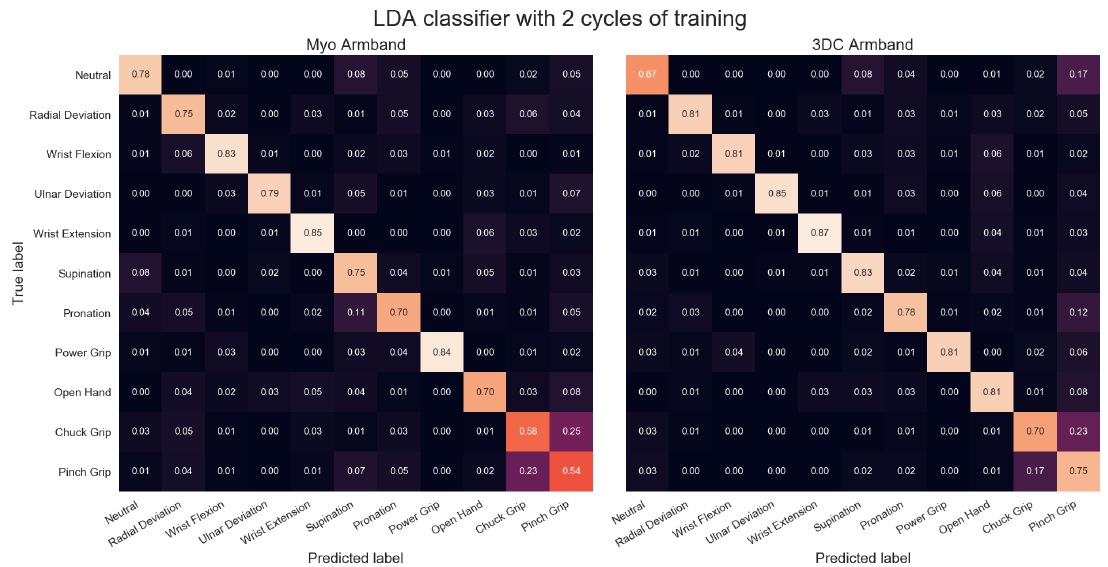
Figure A2. Confusion Matrices for the Myo and the 3DC Armband employing LDA for classification and two cycles of training. Lighter is